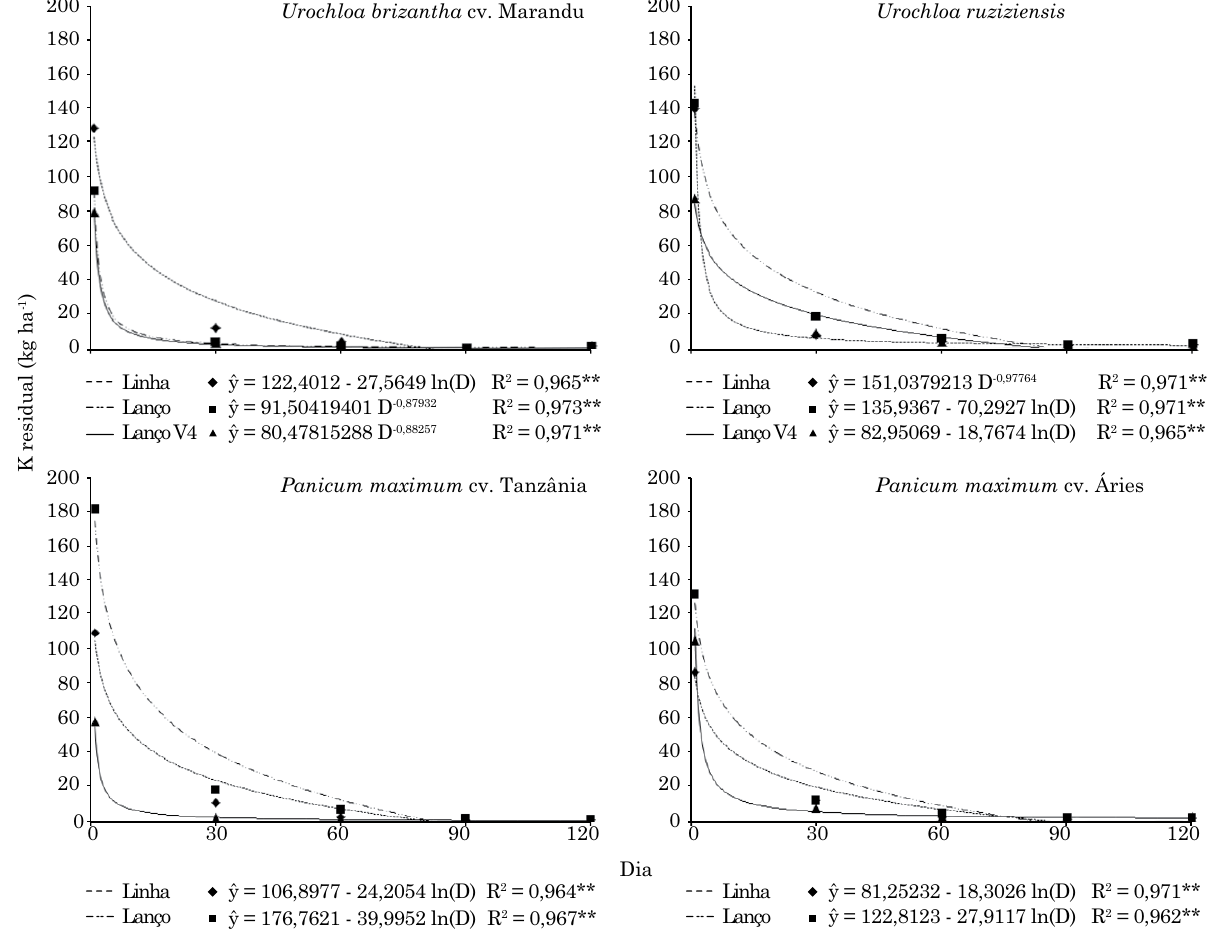
Figura 4. Potássio residual na palhada das forrageiras remanescente no solo até 120 dias durante o cultivo da soja, para as condições das forrageiras semeadas no plantio do milho, na linha (Linha) ou a lanço (Lanço) ou no estádio V4 a lanço (LançoV4). **